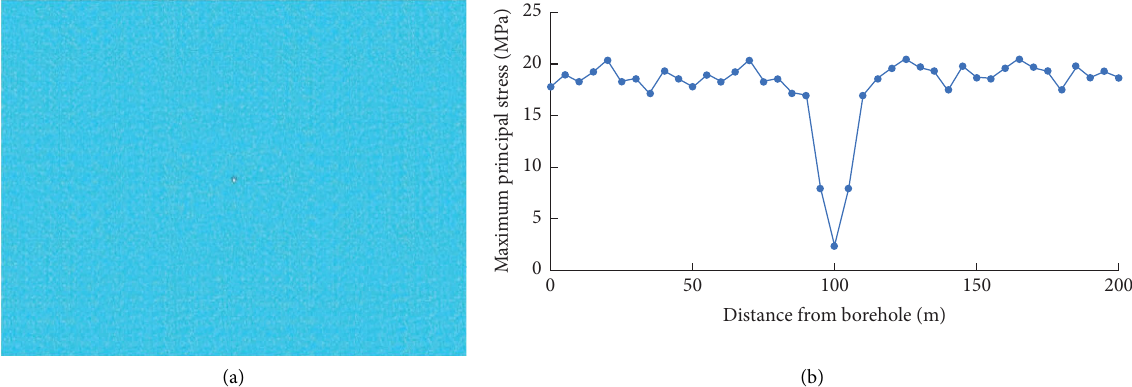
Figure 5: Fracture and stress distribution of coal seam after drilling. (a) Distribution of fractures. (b) Stress distribution condition.